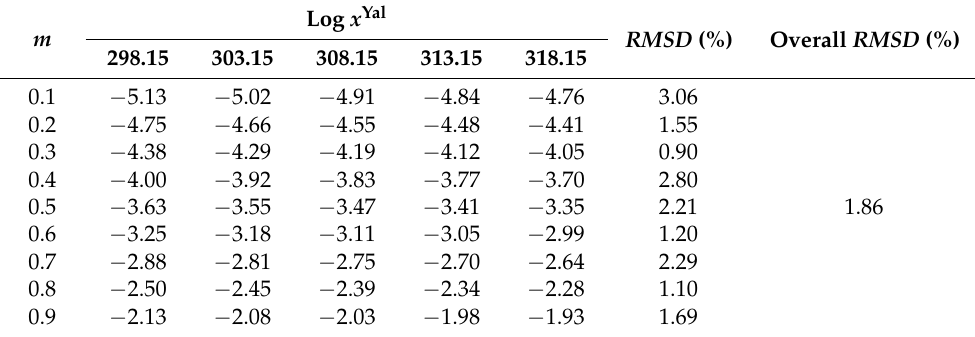
Table 10. Log x Yal values of TRV calculated using the Yalkowsky–Roseman model in various PG + water compositions at 298.2–318.2 K.